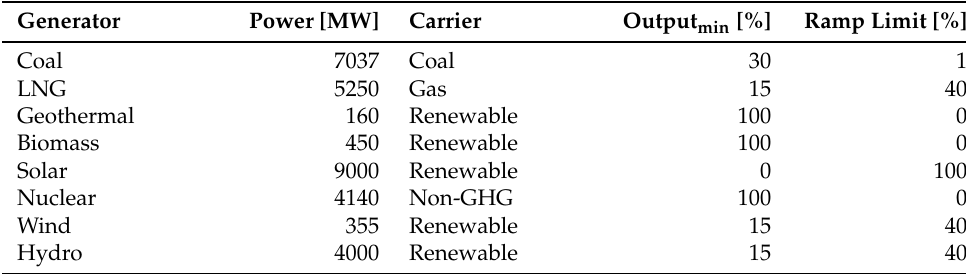
Table 2. Generators in Kyushu as of FY2019.